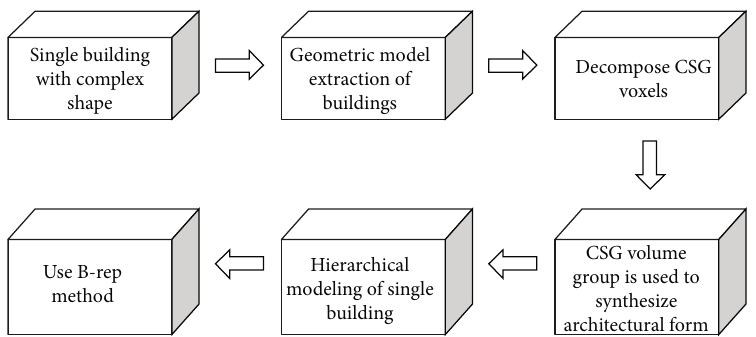
Figure 2: General idea of CsG/B-rep hybrid modeling for single